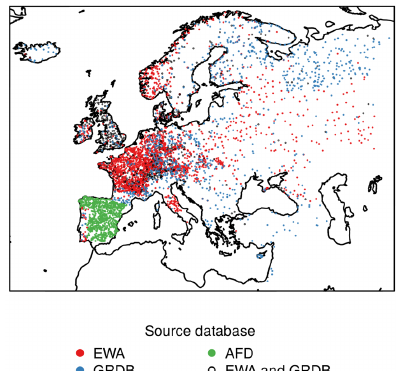
Figure 1. Locations of streamflow stations, stemming from the three considered data collections. Records from the EWA and the GRDB that were identified as very likely identical are indicated by black